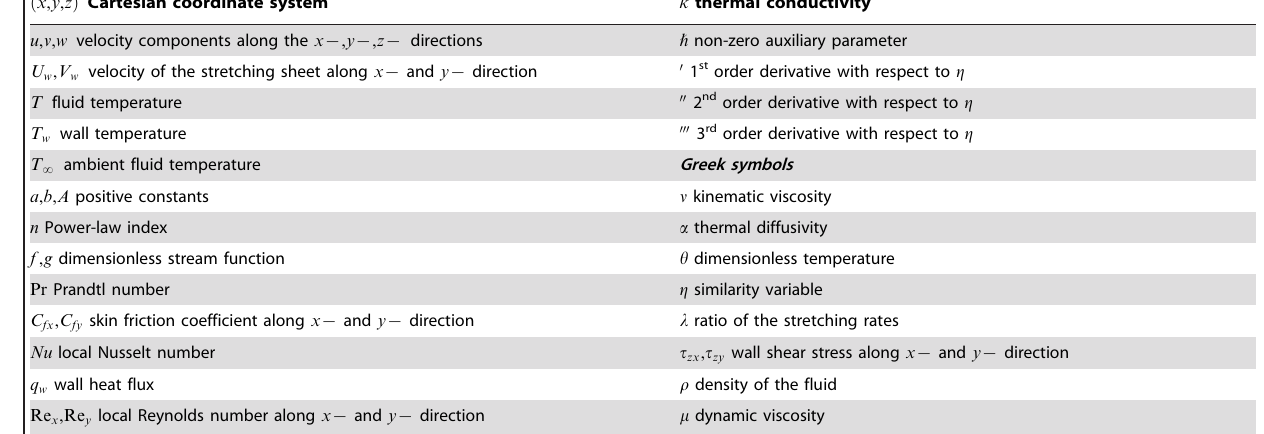
Table 1. List of